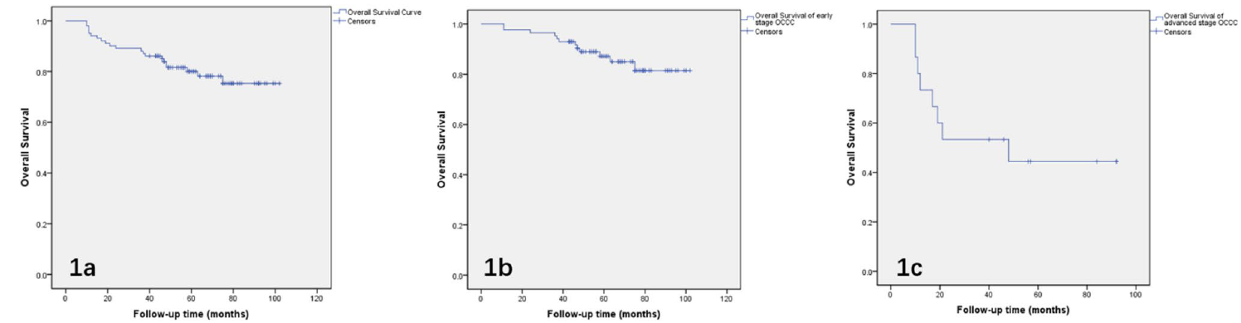
Fig. 1 a. Survival curves of overall survival; b . Survival curves of overall survival in early stage OCCC (FIGO stage I and II); c . Survival curves of overall survival in advanced stage OCCC (FIGO stage III and